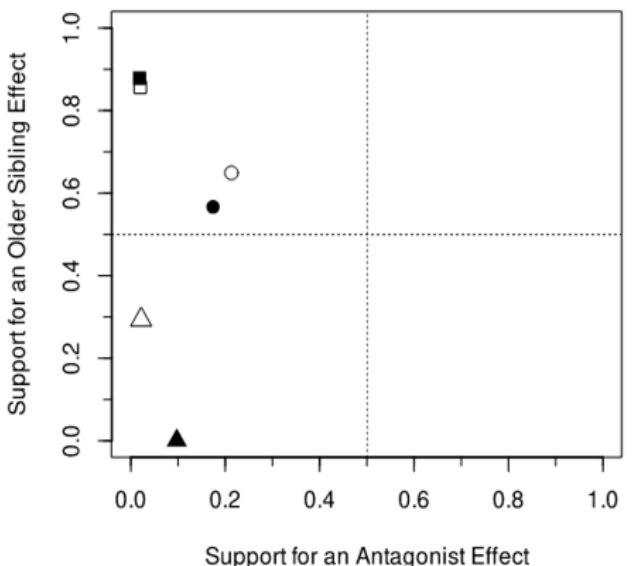
Figure 4. Support for an antagonist effect (AE) or an older sibling effect, conjointly modelled. Coordinates of each point represents the support for AE in presence of an older sibling effect (x-axis), and the support for an older sibling effect in presence of an AE (y-axis). The older sibling effect is either an older brother effect (FBOE, full symbol), or an older sister effect (SBOE, open symbol). Point shapes vary according to datasets (circle, square, and triangle for Indonesia, Greece, and France,